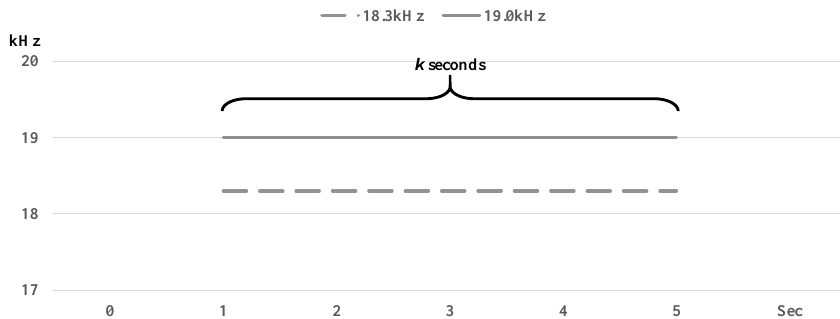
Fig. 2. An example of proposed a pair high frequencies signal for smart ordering